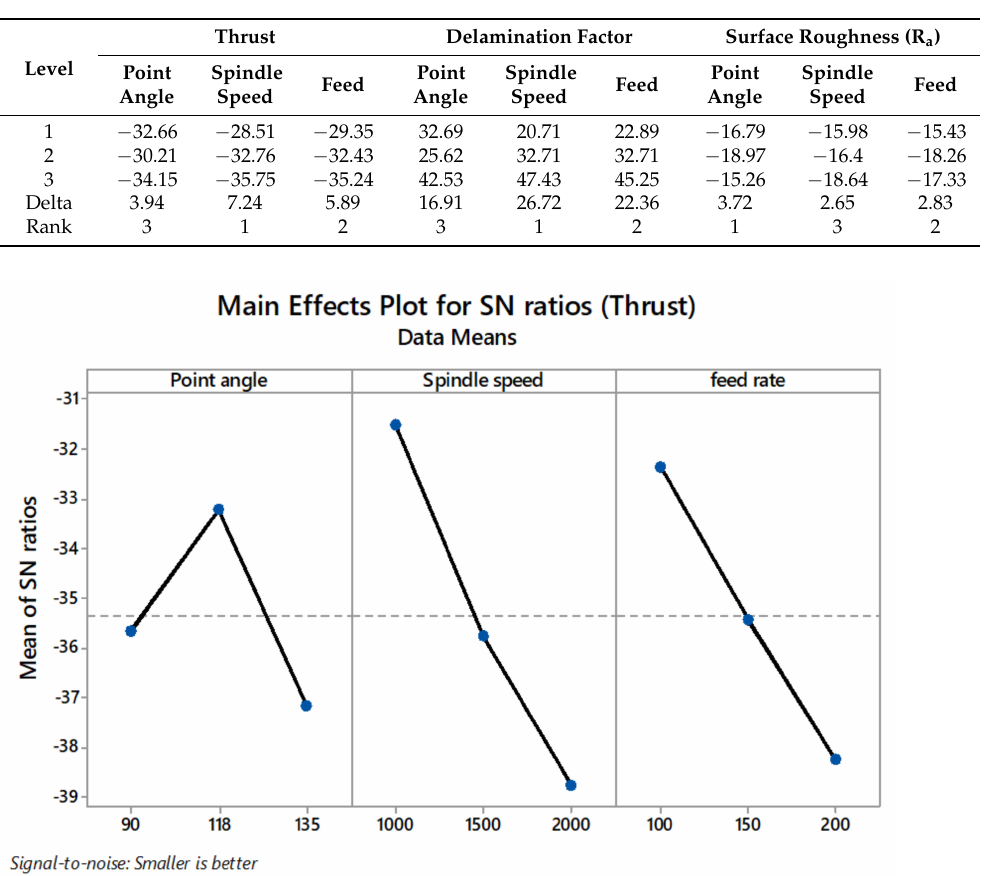
Table 7. S/N ratio response table.